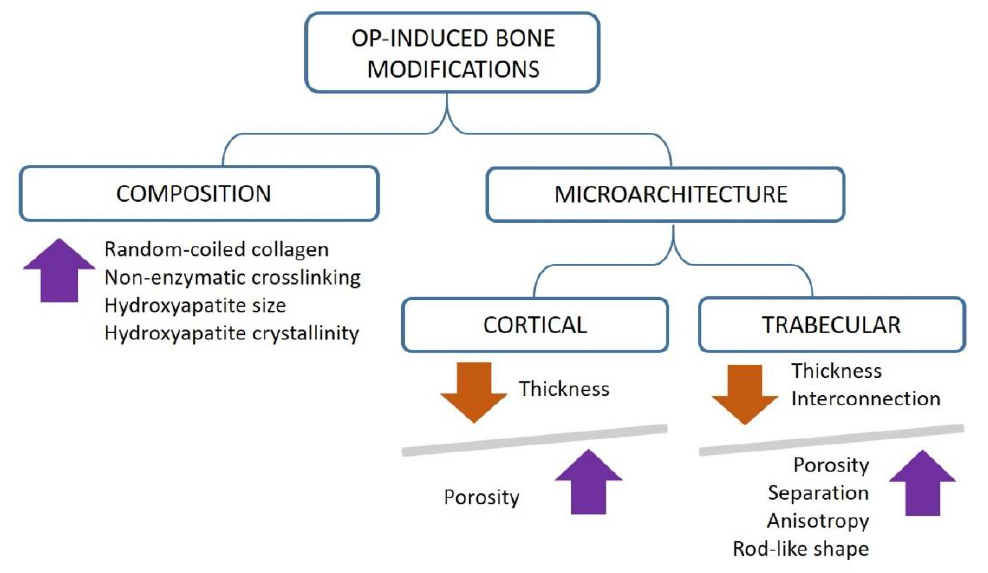
Figure 6. Schematic overview of the OP-induced modifications of bone quality.